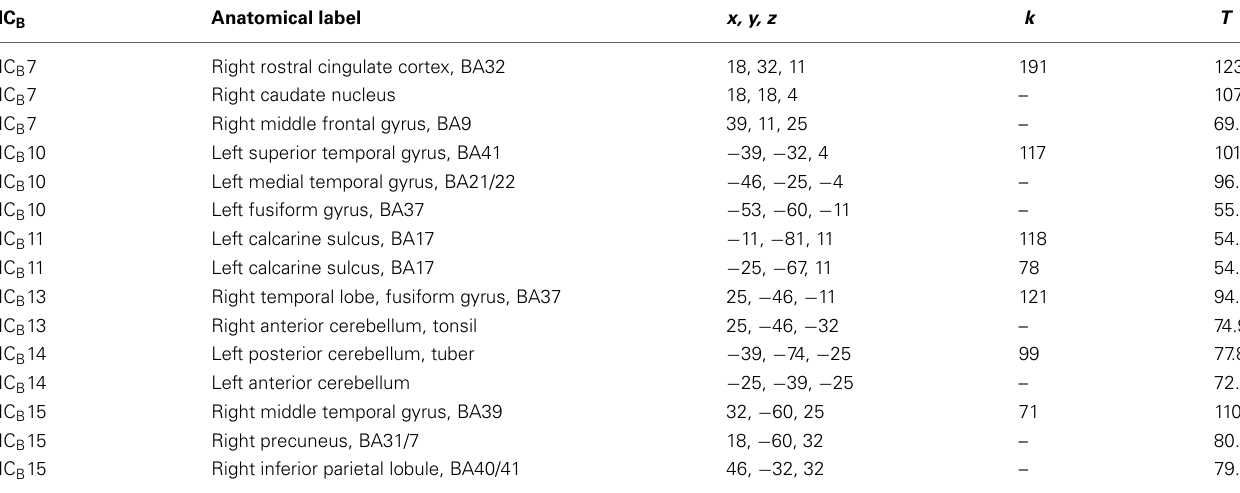
Table 2B | Anatomical labels, Talairach coordinates, cluster sizes, and T -values of independent components clusters seen during peri-stimulus period (IC B